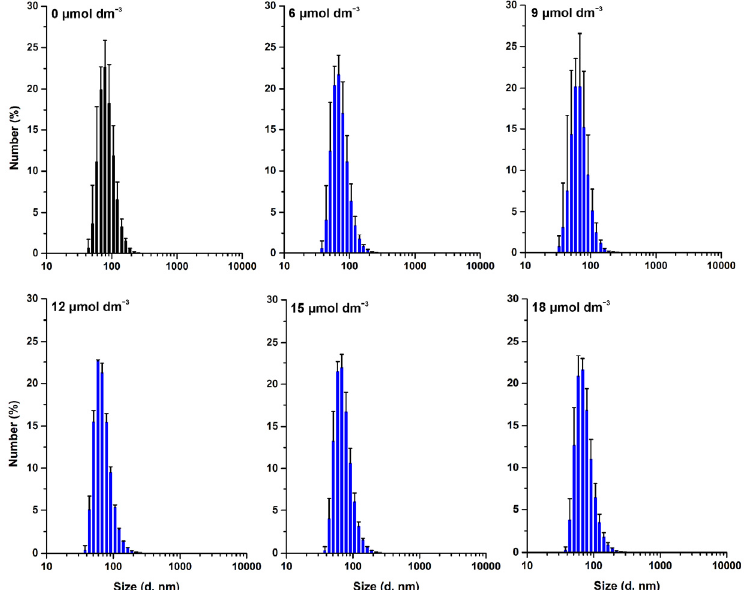
Figure 5. Size distribution of the POPC:POPG (3:1) LUVs in the presence of W-BP100 from the DLS measurements. Number-weighted size distribution of 100 µmol dm − 3 POPC:POPG (3:1) LUVs in the absence and presence of increasing W-BP100 concentrations (6-18 µmol dm − 3 ), upon 10 min of incubation, at 25.0 ± 0.1 °C. Data are the mean ± SD of three replicate measurements (one single experiment).